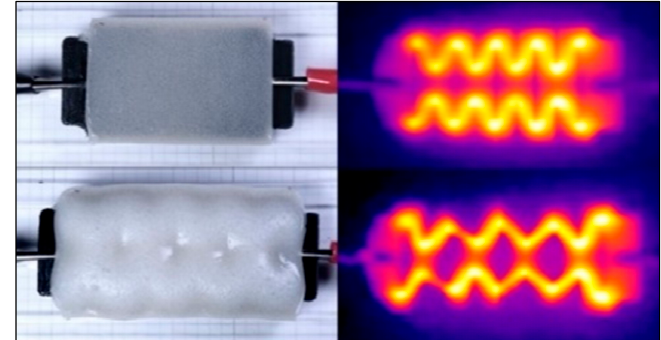
Figure 1. Fabric heater in silicone-ethanol thermal actuator. ( Top left ) Actuator before actuation; ( Bottom left ) Fully actuated actuator; ( Top right ) Thermal imaging of actuator heating up; ( Bottom right ) Thermal imaging of fully actuated actuator.